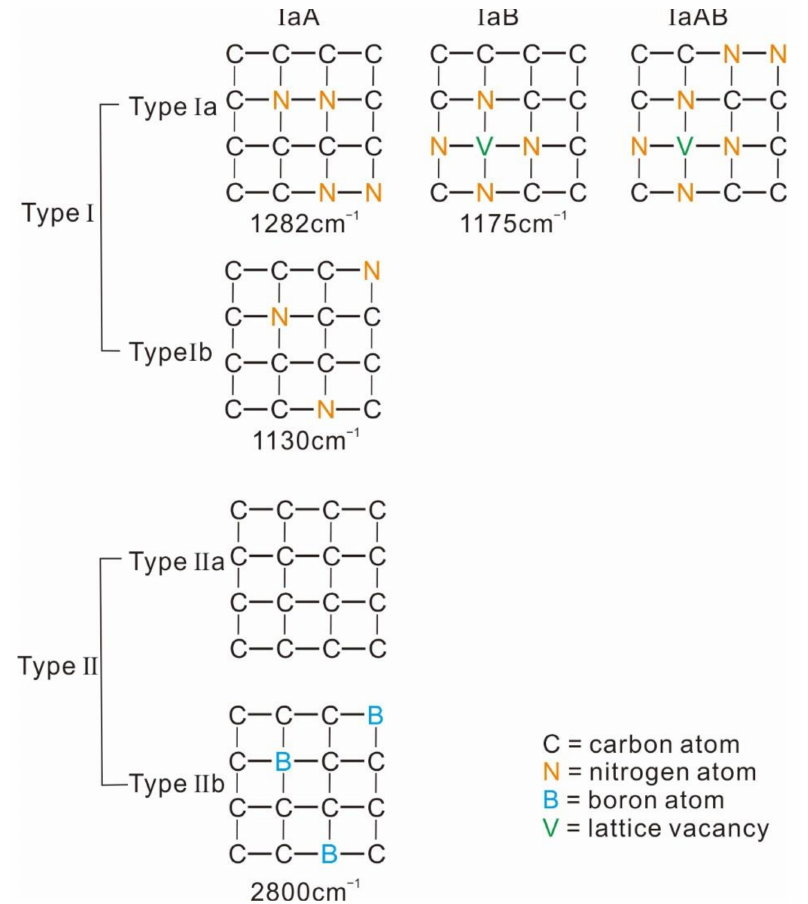
Figure 7. N and B atoms replace C atoms in various types of diamond lattice